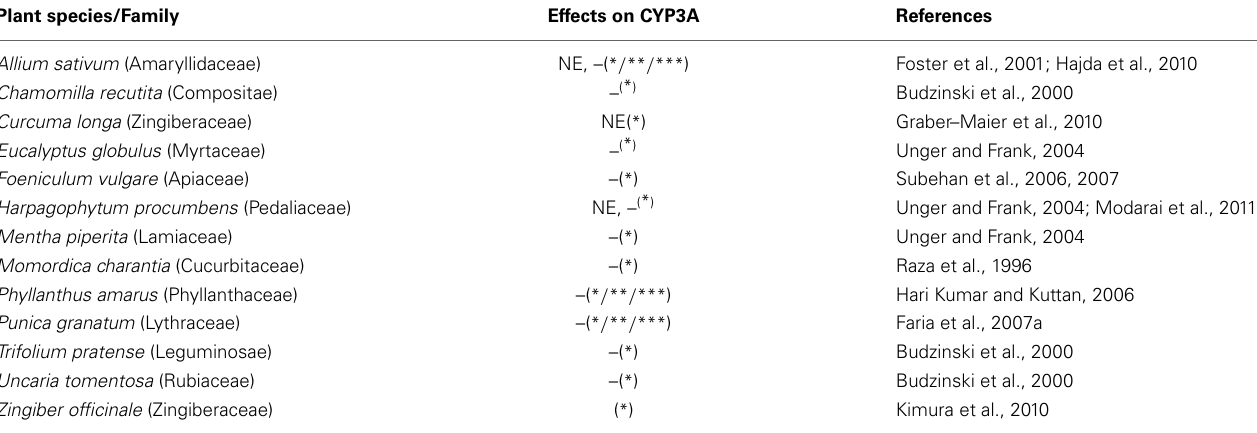
Table 6 | Medicinal plant species listed in RENISUS with reported effects of on CYP3A. Plant